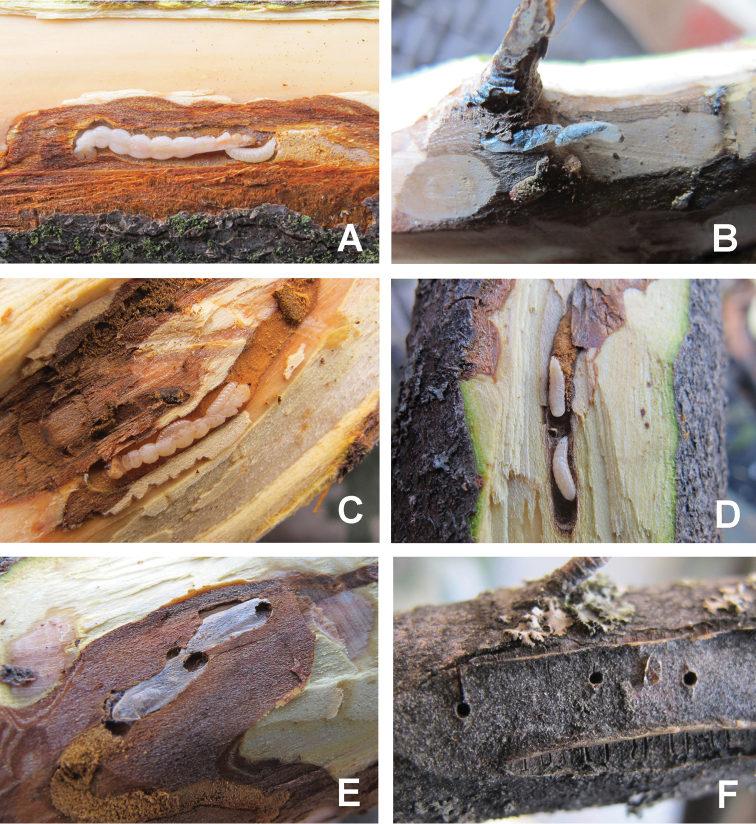
A Larva of Atanycolus
ivanowi on larva of A.
maliB Cocoons of Atanycolus
ivanowiC Third instar larvae of Doryctes
undulatusD Fourth instar larvae of Doryctes
undulatusE Empty cocoons of Doryctes
undulatusF Emergence hole of Doryctes
undulatus.